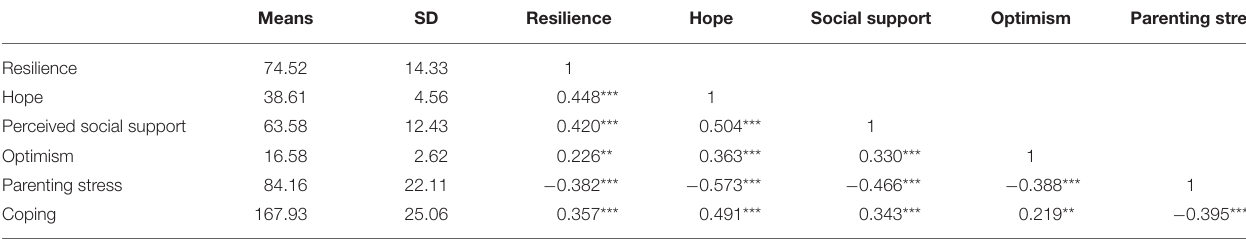
TABLE 4 | Descriptive statistics and correlations in continuous variables among mothers ( n =